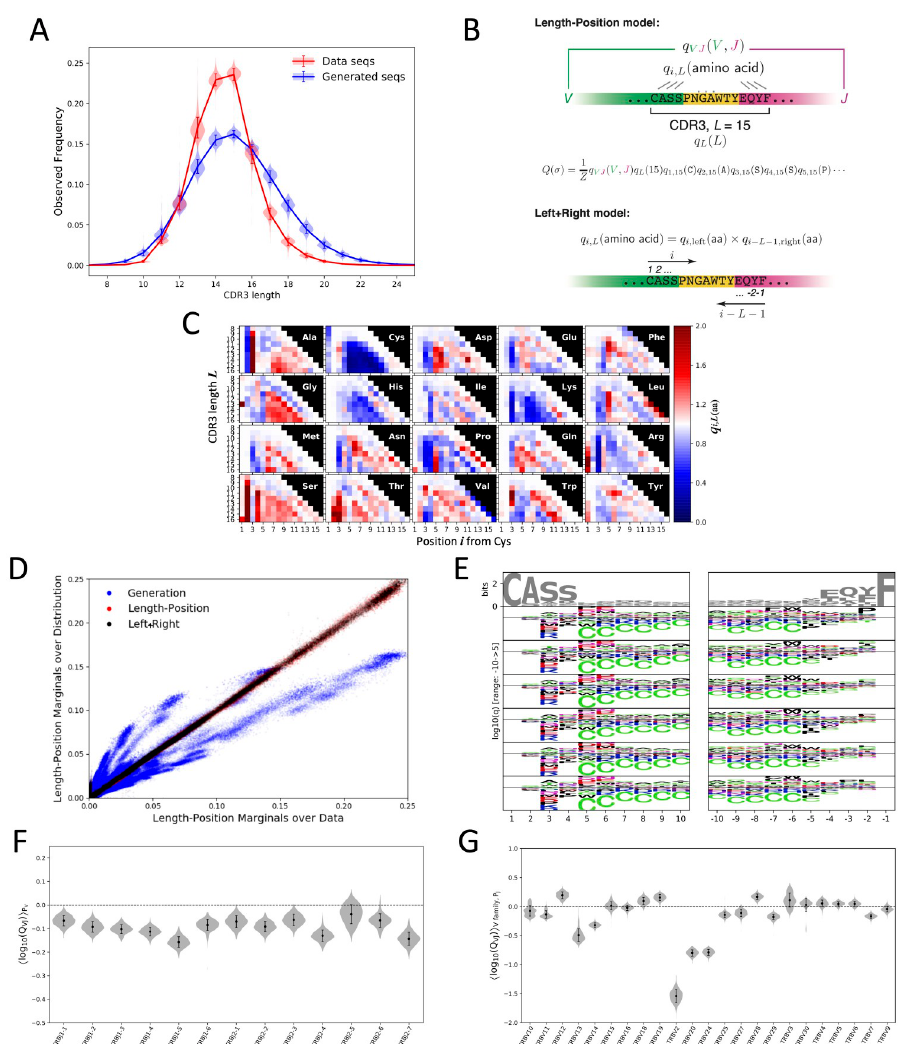
Fig 4. Selection models of 651 individuals. (A) Length distribution of the Complementarity Determining Region 3 (CDR3) of TRB before (as predicted by the P gen model in blue), and after (data, in red) selection. Violin plots show variability across individuals. (B) Illustration of the LengthPosition and Left+Right SONIA models. Both models have the same selection features for gene choice q and CDR3 length q . The LengthPosition model has features for amino VJ L acid/position/length combinations q i , L ( aa ) while the Left+Right model factorizes those terms into two terms indexing the amino acid from the left and right edges of the CDR3, i.e. q ( aa ) = q ( aa ) × q ( aa ). (C) Amino-acid i , L i ,left i − L − 1,right selection factors q i , L of the LengthPosition model as a function of position i and L for each of the 20 amino acids. The color scale indicates if a selection factor is above (red) or below (blue) neutral selection. These factors are consistent with previous reports on a smaller cohort [17]. (D) Model prediction for the frequencies of all features of the LengthPosition model (V,J joint usage, CDR3 length, and amino acid usage at each position and length). The Left +Right model describes the marginals despite not learning them directly. (E) Sequence logos illustrating amino-acid selection factors of the Left+Right model. The first row shows non selected amino acid usage as standard sequence (aa)) and left (log 10 q (aa)) for 6 individuals. We include a logos while the subsequent rows show right (log 10 q i ,left i ,right line for neutral selection, q i (aa) = 1, for clarity. (F,G) Distributions of marginal selection factors for J genes and V gene families over the population (calculated by averaging q over the relevant V gene and/or J gene probabilities). VJ